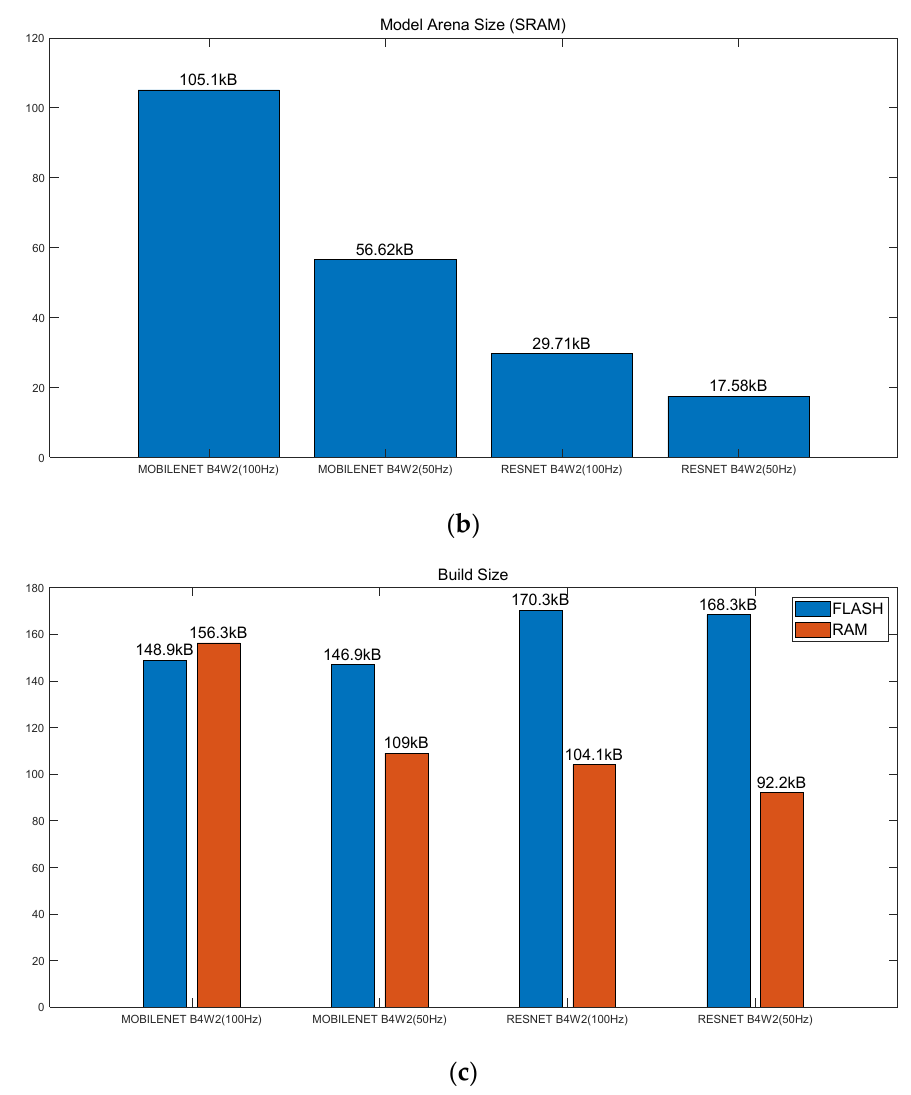
Figure 5. Model Size ( a ) Model Size (FLASH) ( b ) Model Arena Size (SRAM) ( c ) Model Build Size.